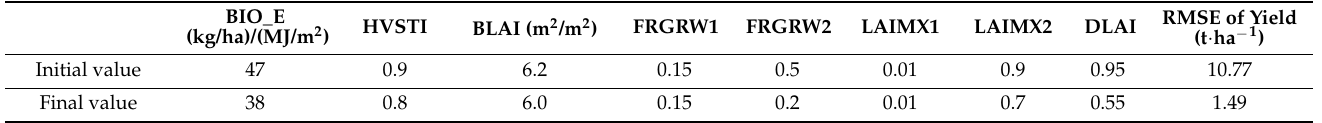
Table 3. Parameter setting for Napier grass in the SWAT model crop file, and the RMSE of yield by initial and final values after